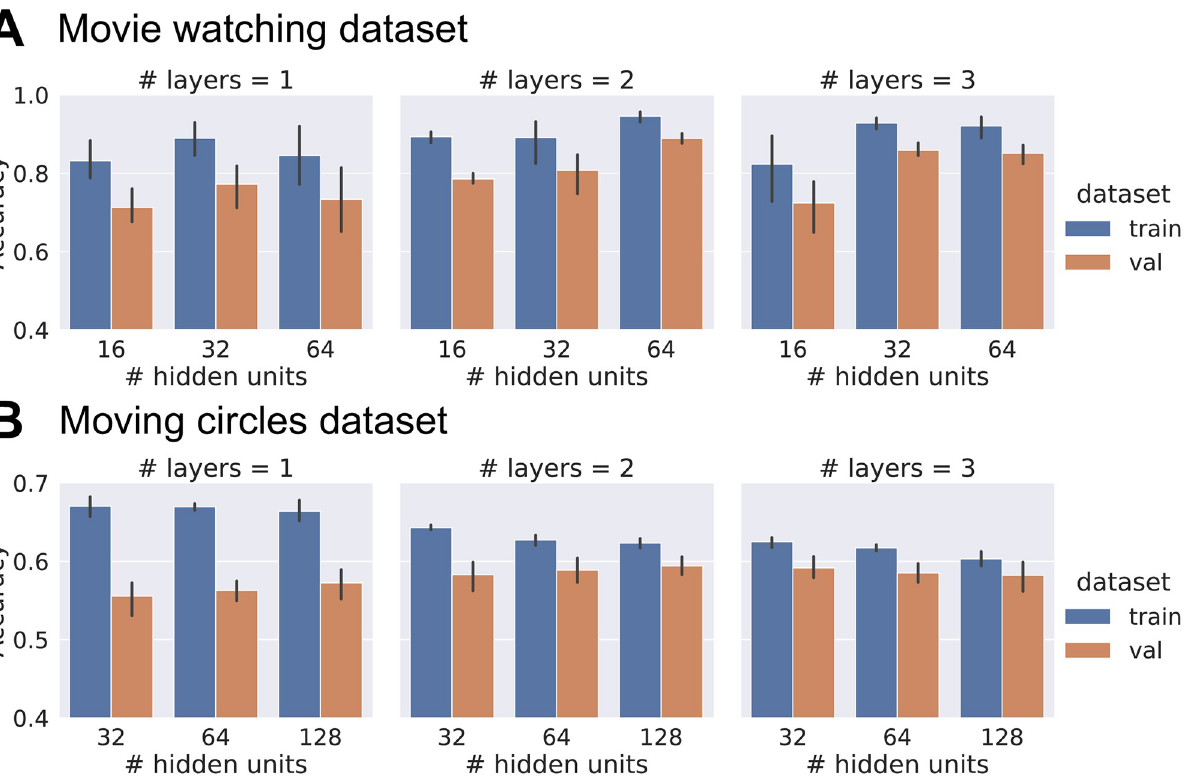
Fig 8. Selection of model architectures via cross validation on data from 100 participants. Val: validation portion of training data. Error bars show 95% confidence intervals across folds.